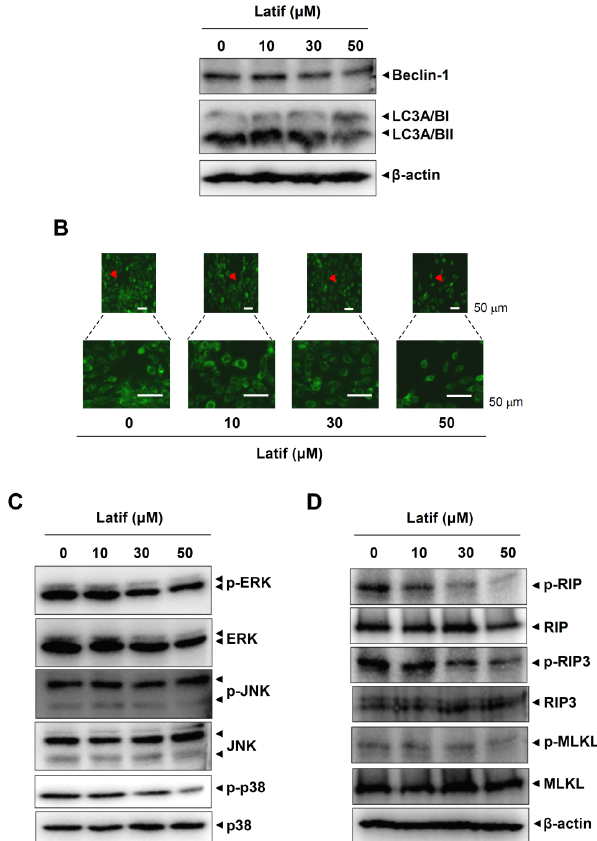
Figure 5. Effects of Latif on autophagy and necroptosis in human YD-10B OSCCs. ( A ) Amounts of 10, 30, and 50 μ M Latif was treated for 24 h in YD-10B OSCCs, and then Beclin1, LC3A/BI, and LC3A/BII expressions were assessed using western blot analysis. ( B ) Cells were treated with 10, 30, and 50 μ M Latif, and then DAPGreen-positive autophagosome was observed using a fluorescence microscope. Arrowheads: Magnfied region. ( C ) Phospho-ERK1/2 (p-ERK1/2), ERK1/2, phospho-JNK (p-JNK), JNK, phospho-p38 (p-p38), and p38 levels were assessed using western blot analysis. ( D ) The cells were treated with Latif, and phospho-RIP (p-RIP), RIP, phospho-RIP3 (p-RIP3), RIP3, phospho-MLKL (p-MLKL), and MLKL were analyzed using Western blot analysis. The β -actin level was detected as a loading control. Data are representative of the results of three experiments.